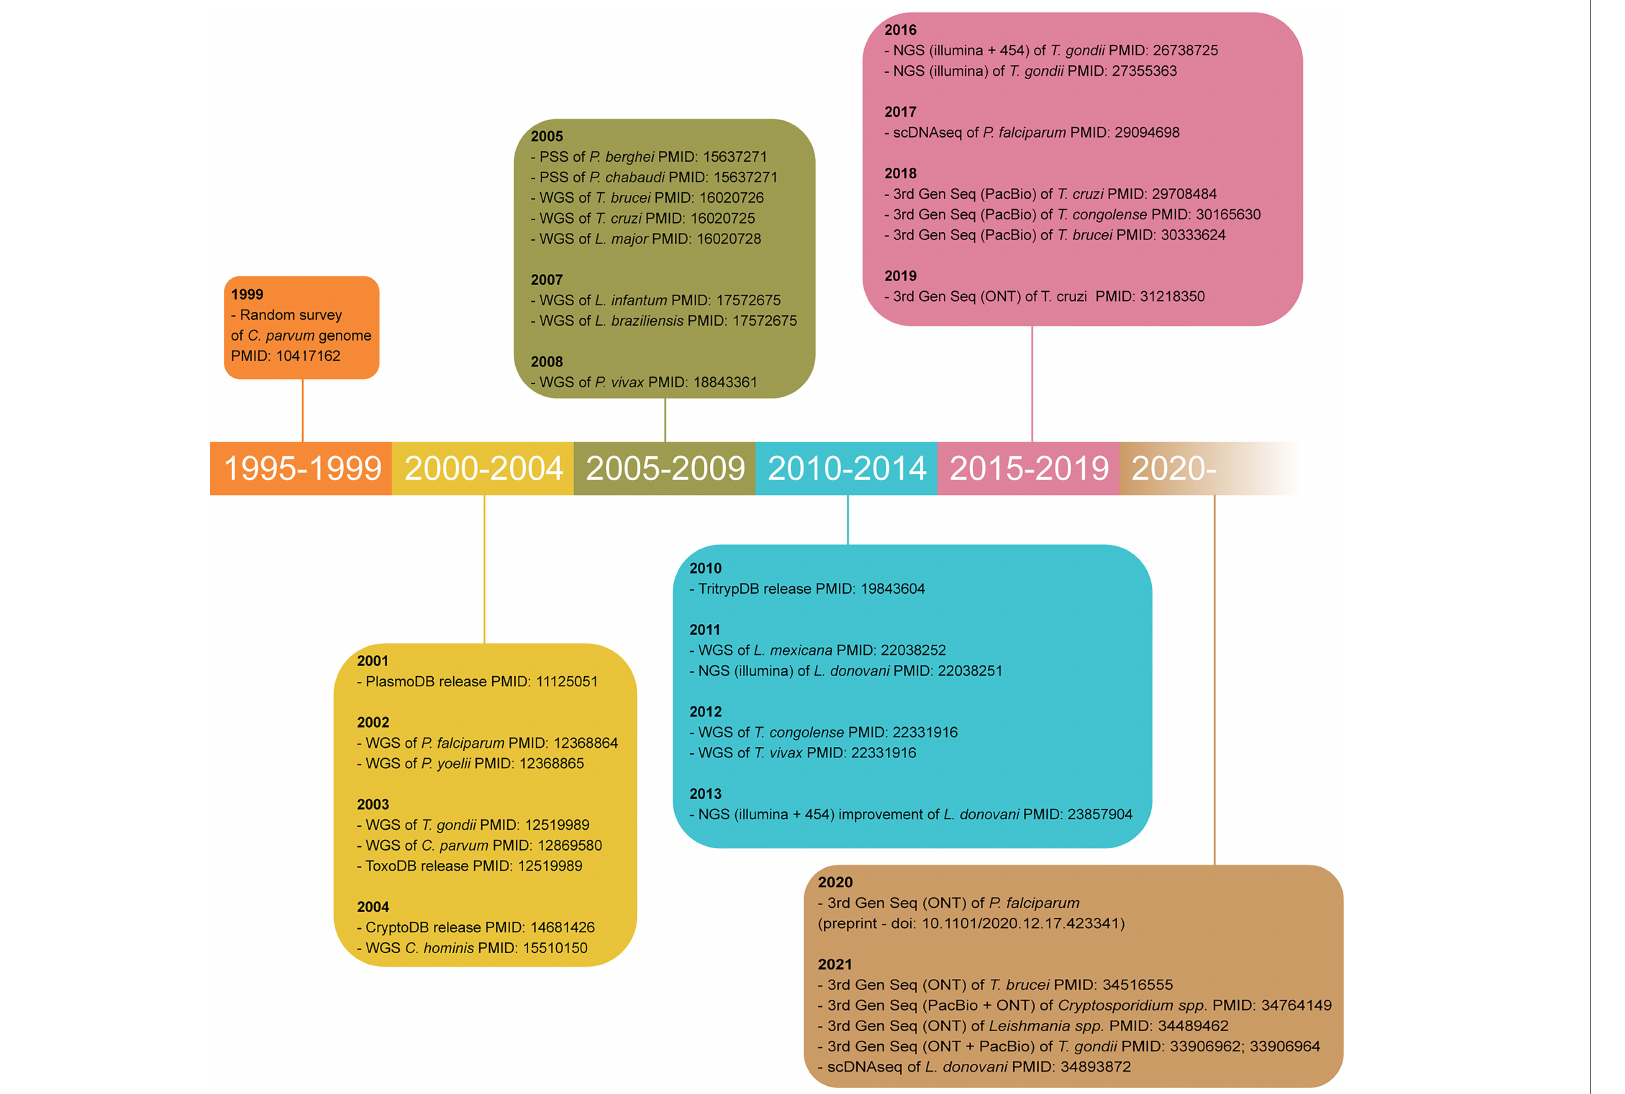
FIGURE 3 | Timeline of major achievements in parasite genome sequencing. Only the oldest article using each technology for each parasite is cited. WGS, whole genome shotgun sequencing; PSS, partial shotgun sequencing; 3 rd Gen Seq, third generation sequencing or long-read sequencing; ONT, Oxford Nanopore technology; PacBio, Paci fi c Biosciences; PMID, PubMed identi fi cation